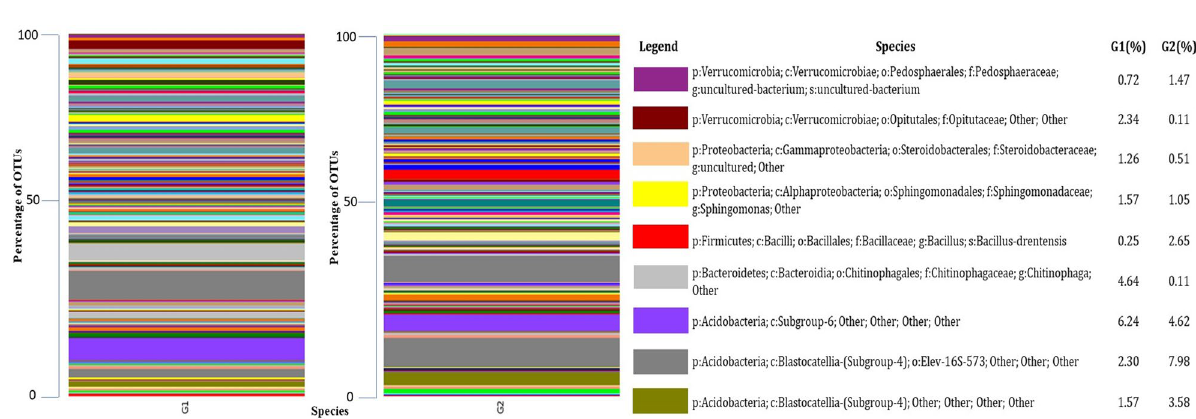
Figure 5. Comparative microbiome (a-family and b-genus) analysis of organic (G1) and conventional (G2) treated mango orchards soil by using metagenomic (V3 and V4 region) approach.